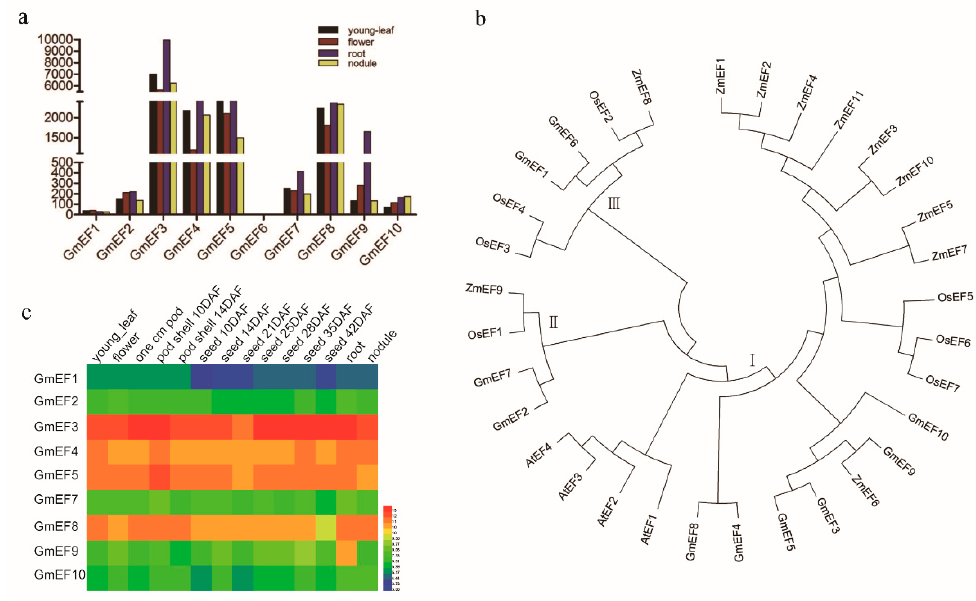
Figure 3. Differential expression analyses of soybean EF1 α family members, neighbor-joining phylogenetic tree of EF1 α members from Glycine max ( Gm ), Arabidopsis ( At ), Zea mays ( Zm ), and Oryza sativa ( Os ), and subcellular localization of GmEF4. ( a ) Expression data were extracted from soybean transcriptome data in SoyBase. In this respect, a transcriptionally active gene is a gene that has two or more sequence reads at one or more of the tested tissues/developmental stages. ( b ) Multiple sequence alignment was performed using the Clustal X program, and the phylogenetic tree was constructed using the neighbor-joining method. AtEF1 (AT1G07920), AtEF2 (AT1G07930), AtEF3